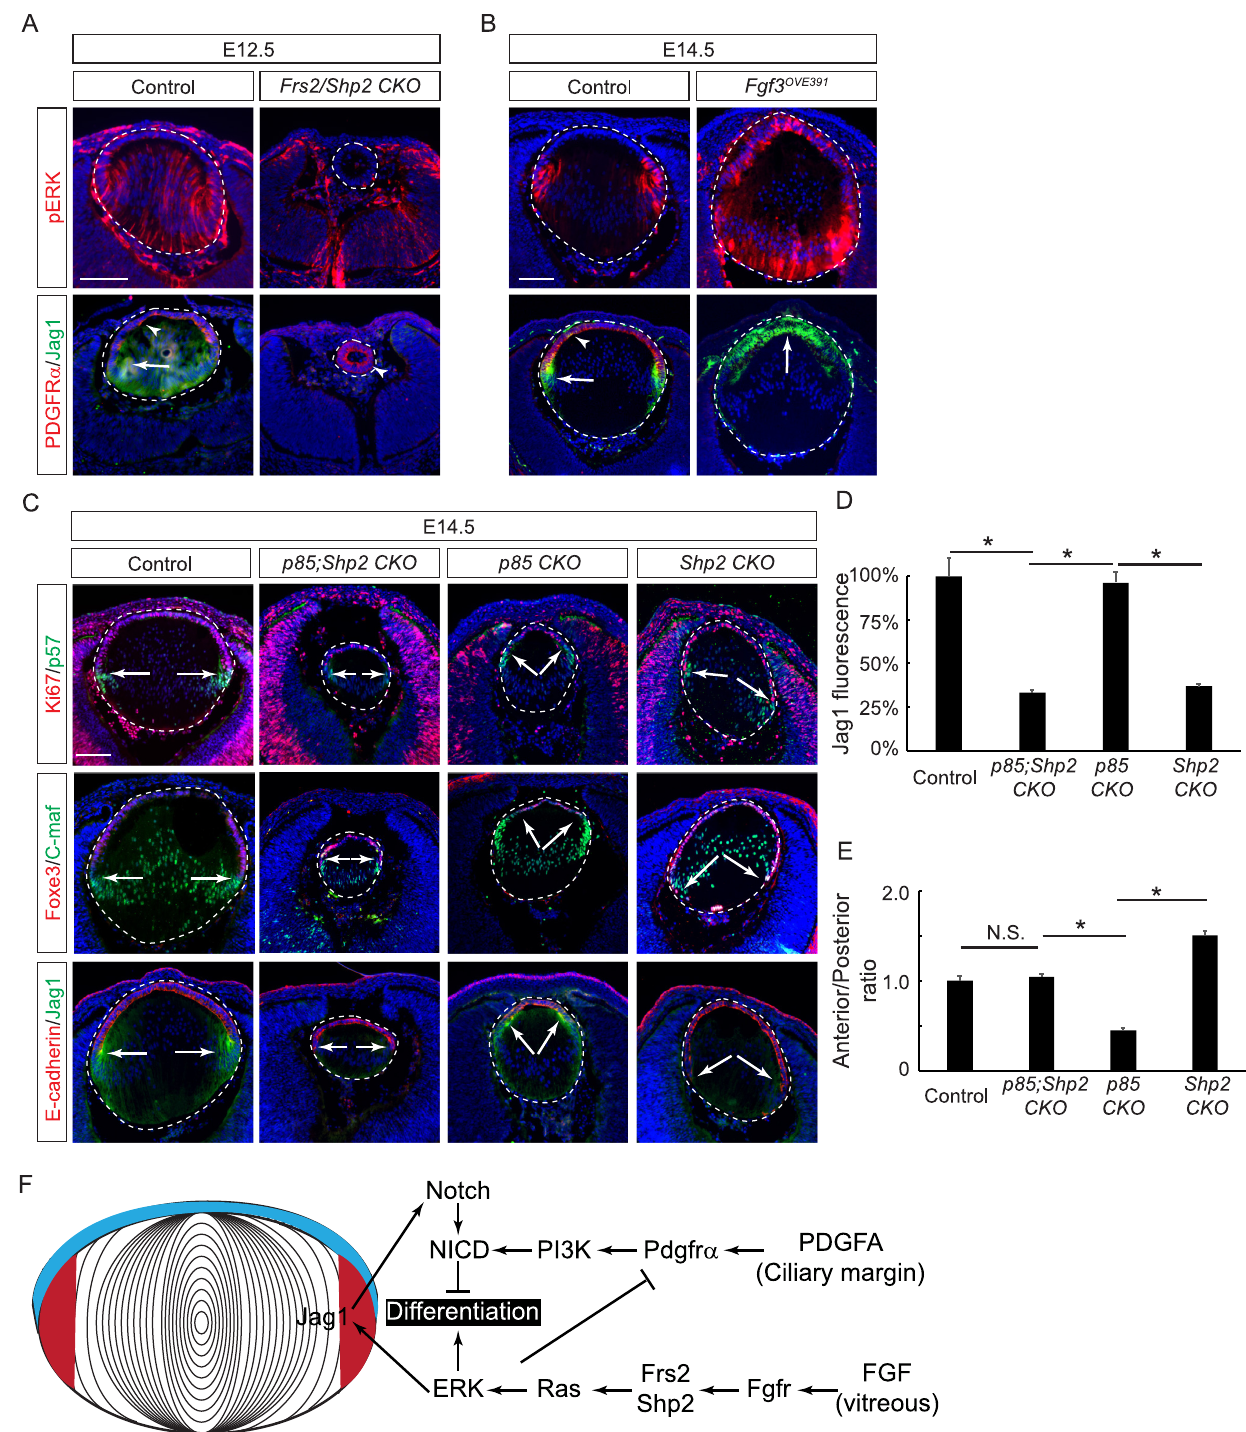
Fig 7. FGF–Shp2 signaling induces the expression of the Notch ligand while also antagonizing the PDGF–PI3K pathway. (A) Deletion of FGF-signaling mediators Frs2 and Shp2 abolished ERK phosphorylation and Jag1 expression, leaving the entire lens vesicle expressing PDGFR α . (B) Overexpression of Fgf3 resulted in increasing ERK phosphorylation and anterior expansion of Jag1 expression at the expense of PDGFR α . Arrows and arrowheads point to Jag1 and PDGFR α staining, respectively. (C) In contrast to the p85 CKO , the Shp2 CKO lens had an extended lens epithelium arc. Deleting Shp2 in the p85 CKO resulted in a smaller lens but a more balanced anterior to posterior ratio. (D) The relative fluorescent intensities of Jag1 at the transitional zones of the lenses. One-way ANOVA test, � P < 0.001, n = 3 embryos for each genotype. (E) Quantification of the anterior and posterior perimeter ratio.